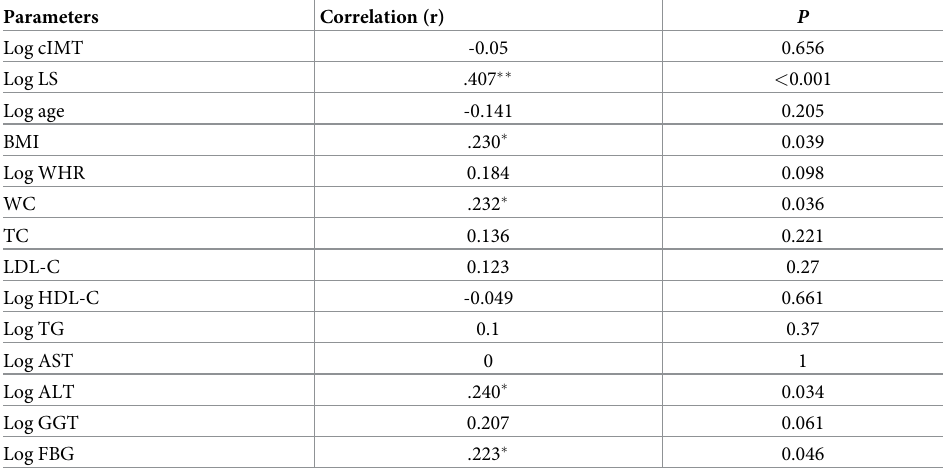
Table 3. Correlation between Log FC VCAM-1 and metabolic and anthropometric parameters. Parameters Correlation (r) P Log cIMT -0.05